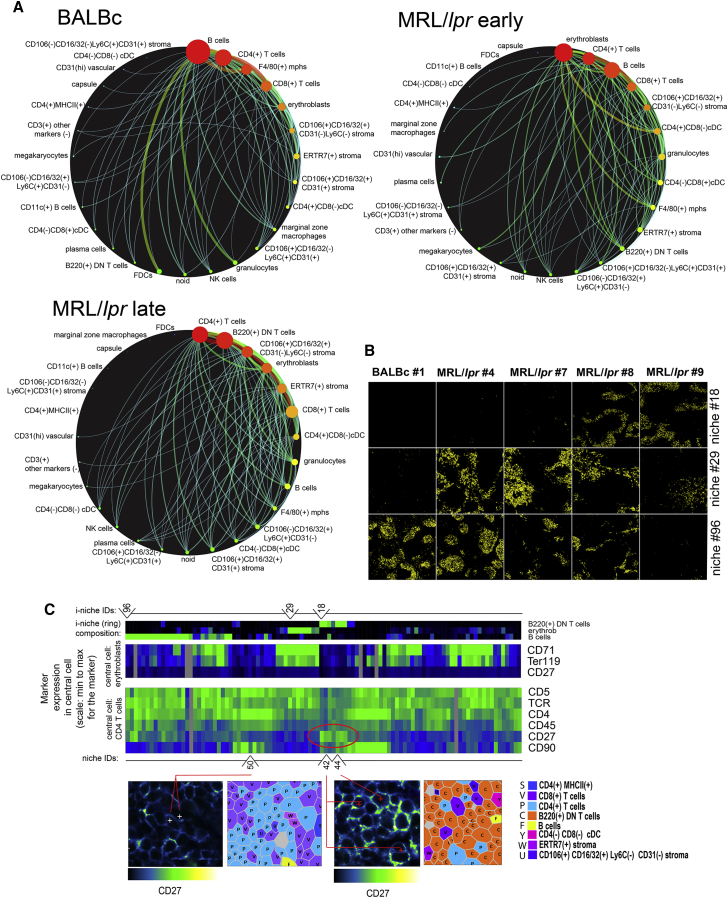
Differential Effect of Disease over i-niche Presence across Dataset(A) Cell-interaction networks built for BALBc early MRL/lpr and late MRL/lpr based on the number of contacts observed between two cell types (only connections with more then 150 interactions per sample are shown on the diagrams). Thickness of connection correlates with number of contacts size of the node indicates number of cells per condition.(B) Evolution of i-niche abundance across dataset. Selected three i-niches (marked above heatmap in C depicting i-niche composition) differentially represented across dataset (changing between norm and disease) are shown. Yellow circles overlaid over blank rectangles corresponding to imaged area indicate location of i-niche.(C) Top heatmap shows frequencies of B220+ DN T cells, erythroblasts, and B cells in the i-niche rings. Line above top heatmap indicates the composition of i-niches 18, 29, and 96 described in (B). Color scheme is the same middle heatmap and indicates expression of selected markers when the i-niche central cell is an erythroblast—primarily to show that CD27 is not expressed on erythroblasts in the vicinity of B220+ DN T cells. Bottom heatmap indicates expression of selected markers when the i-niche central cell is a CD4 T cell. The color schemes in these three heatmaps are the same as in heatmaps in Figures 4B, 4D, and 4E. Red oval outline pinpoints i-niches with elevated CD27. Note that these i-niches as indicated by top heatmap have B220+ DN T cells as a prevailing component. Lower panels show examples of central cells in i-niches marked under the lower heatmap. i-niche 50 is an example of i-niche without B220+ DN T cells. Central cell does not express high CD27. i-niches 42 and 44 have high frequency of B220+ DN T cells and accordingly central cells express high CD27.See also Figures S4K and S4L.